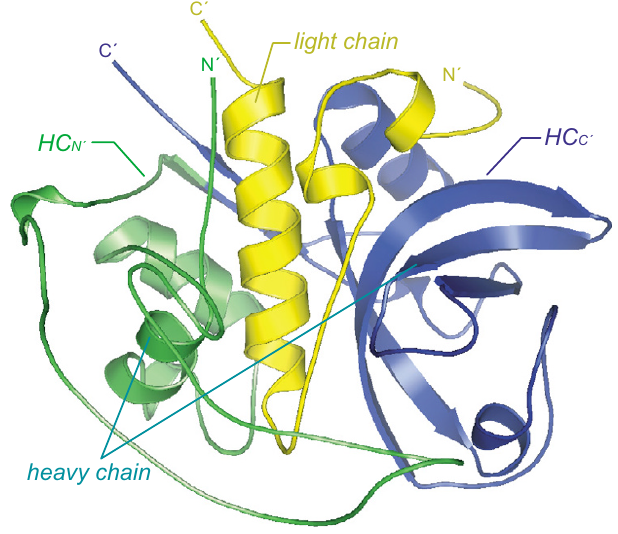
Figure 8 Spatial representation of the mutated sections . The positions of key fragments are indicated within the native mature CB protein. These are the globular domains of the light chain, the heavy chain, and two subunits CB(HC ). The figure serves for illustrational purposes only and does not represent the authentic conformation of the